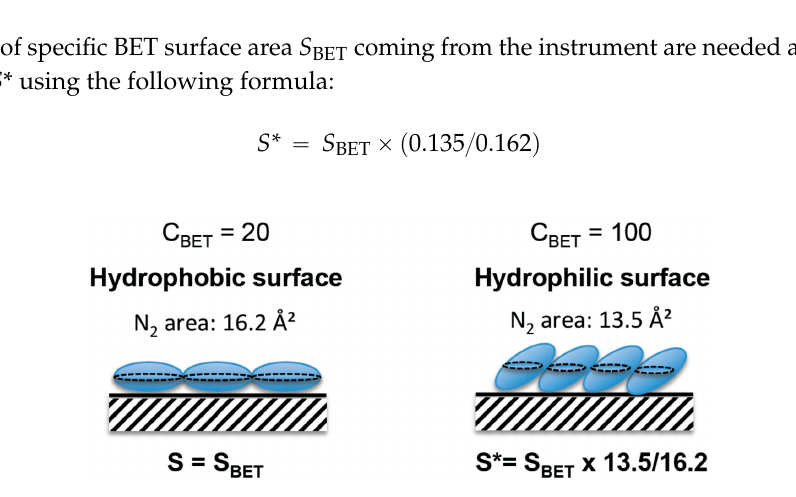
Figure 6. Schematic representation of nitrogen molecules adsorbed at the surface of hydrophobic and hydrophilic materials and the corresponding calculations of specific surface areas.